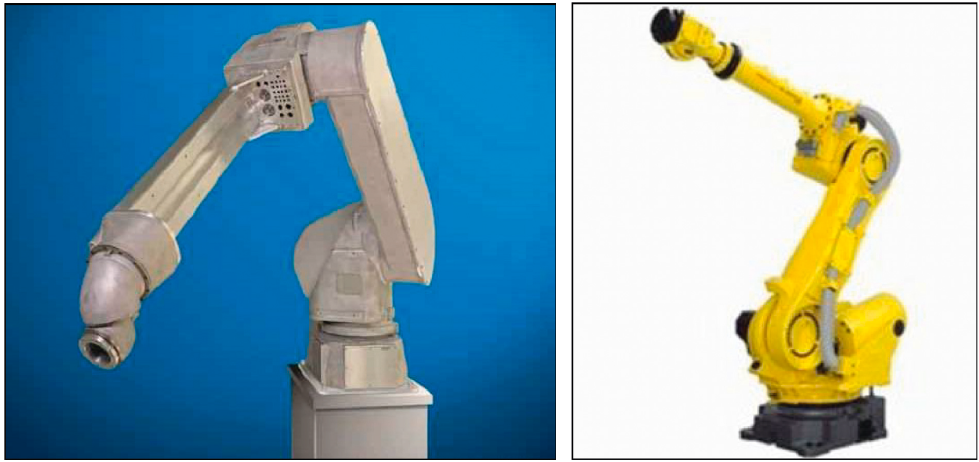
Figure 2: Fancu P-250iB spraying robot. Table 1: Connecting rod parameters of spraying robot.